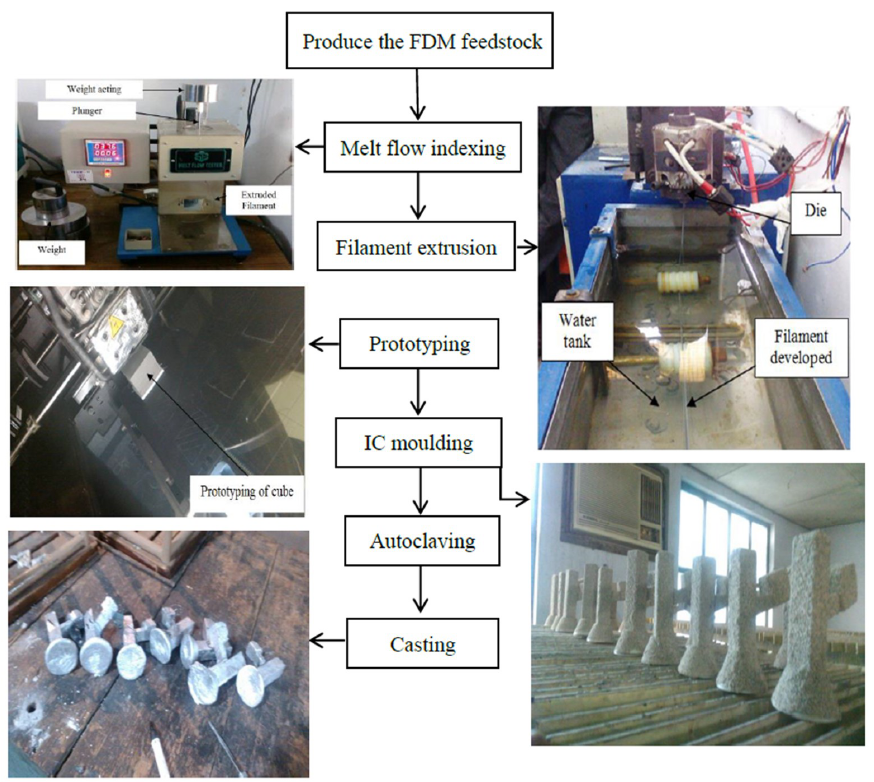
Figure 1. Step by step procedure of aluminium matrix composites (AMC) development.